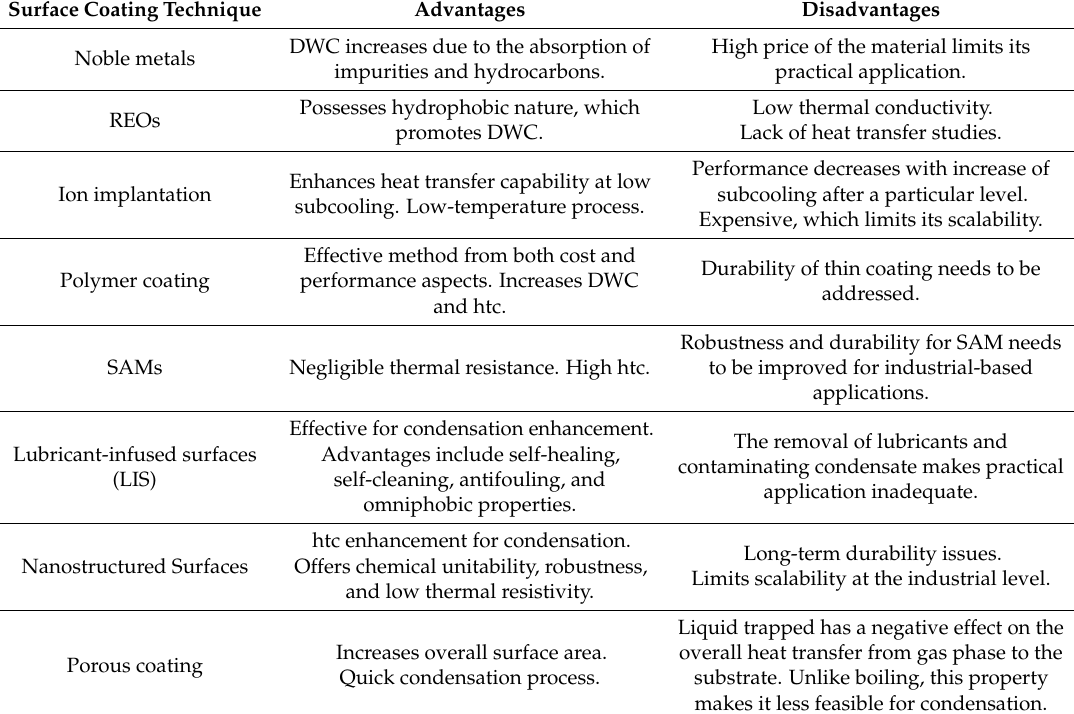
Table 6. Advantages and disadvantages associated with different types of surface